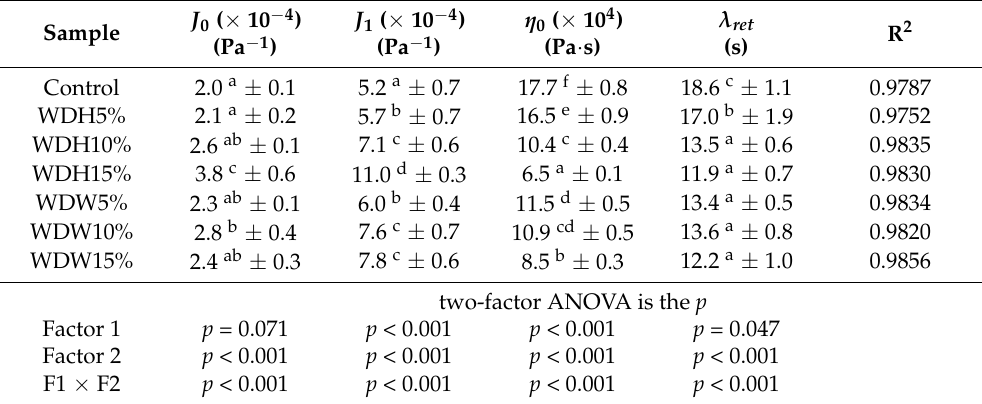
Table 5. Values of the Burgers model parameters for the creep and recovery curves of the wheat doughs with nut